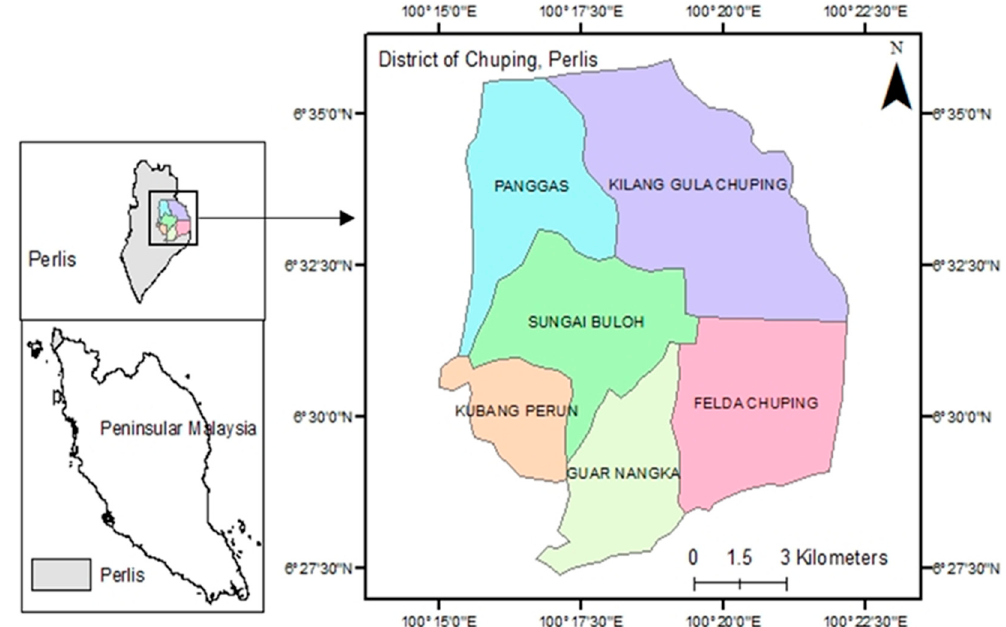
Figure 2. Study area shown using latitute and longitute derived from World Geodetic System 1984 (WGS 1984) expressed in degree unit.